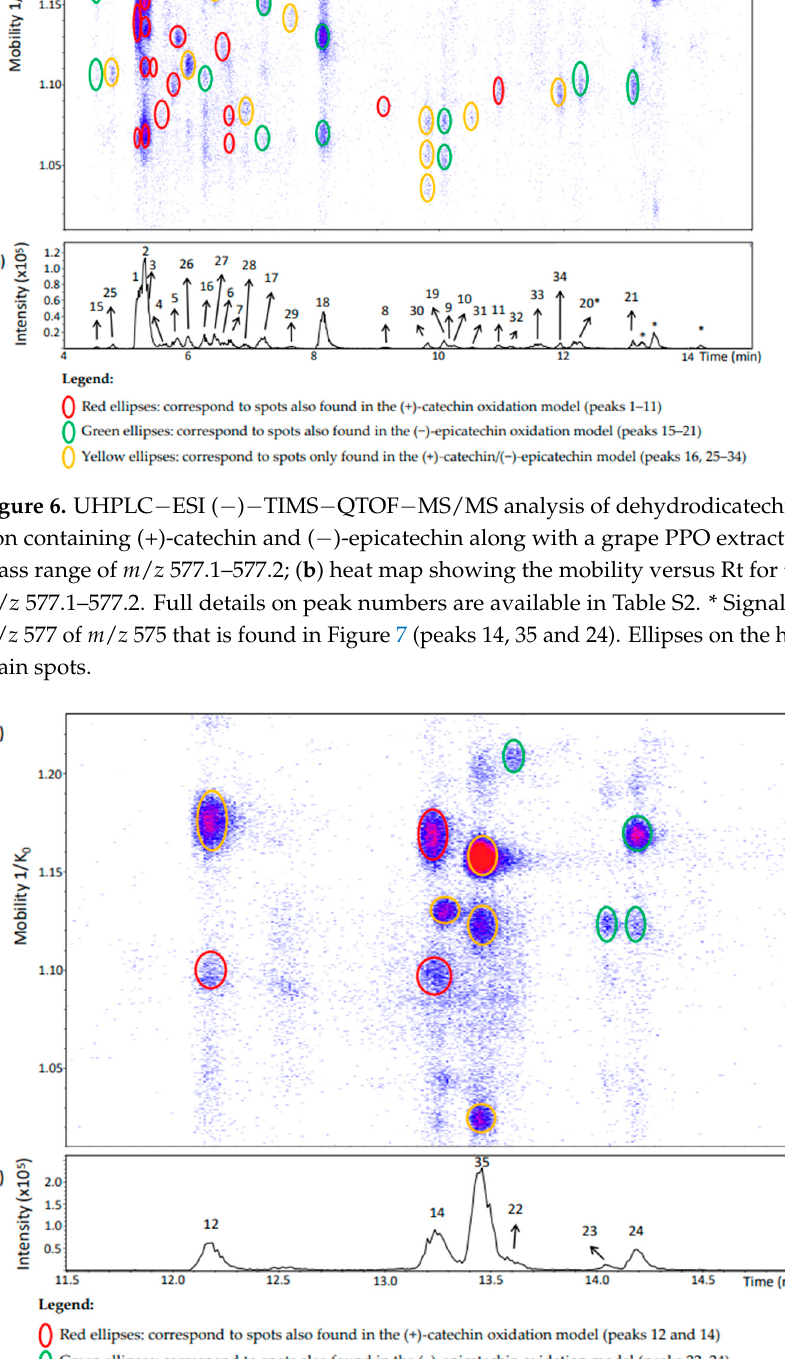
Figure 7. UHPLC − ESI ( − ) − TIMS − QTOF − MS/MS analysis of dehydrodicatechins in model solution containing (+)-catechin and ( − )-epicatechin along with grape PPO extract. ( a ) EIC from the mass range of m / z 575.1–575.2. ( b ) Heat map showing the mobility versus Rt for the mass range of m / z 575.1–575.2. Full details on peak numbers are available in Table S2. Ellipses on the heat map mark the main spots.